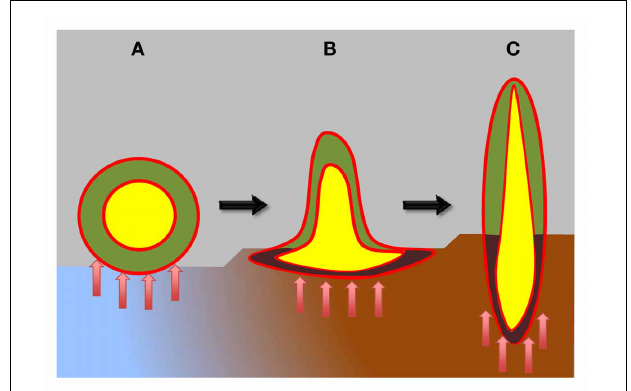
FIGURE 1 | Schematic view of plant body organization in plant evolution. Hypothetical ancient plants are depicted as having atelomic body (A) , resembling lichen-like thallus, while still lacking true shoots and roots. These hypothetical ancient plants already possessed two types of cells: heterotrophic central cells (yellow), protected from the photosynthetic cells by ancient endodermis-like epithel tissue (red). The surface of these ancient plants was likewise protected by ancient epidermis-like epithel tissue (red). During evolution, ancient plants progressively developed shoots and roots (B,C) . Moreover, vascular systems with xylem and phloem parts, as well as the true epidermis and endodermis evolved (red). Epithelium-like lining, known as xylem and phloem parenchyma, covers xylem and phloem elements (not shown in this diagram) that integrate the whole plant bodies into well-coordinated unities. Blue-brown colors depict sea-land transition. Red arrows depict microbial